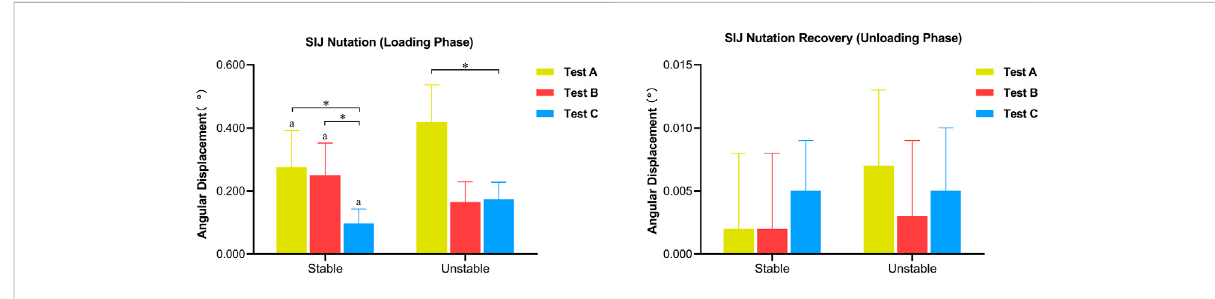
FIGURE 8 Differences in angular displacement of SIJ ( a P < 0.05 vs. unstable SIJ; * p < 0.05).